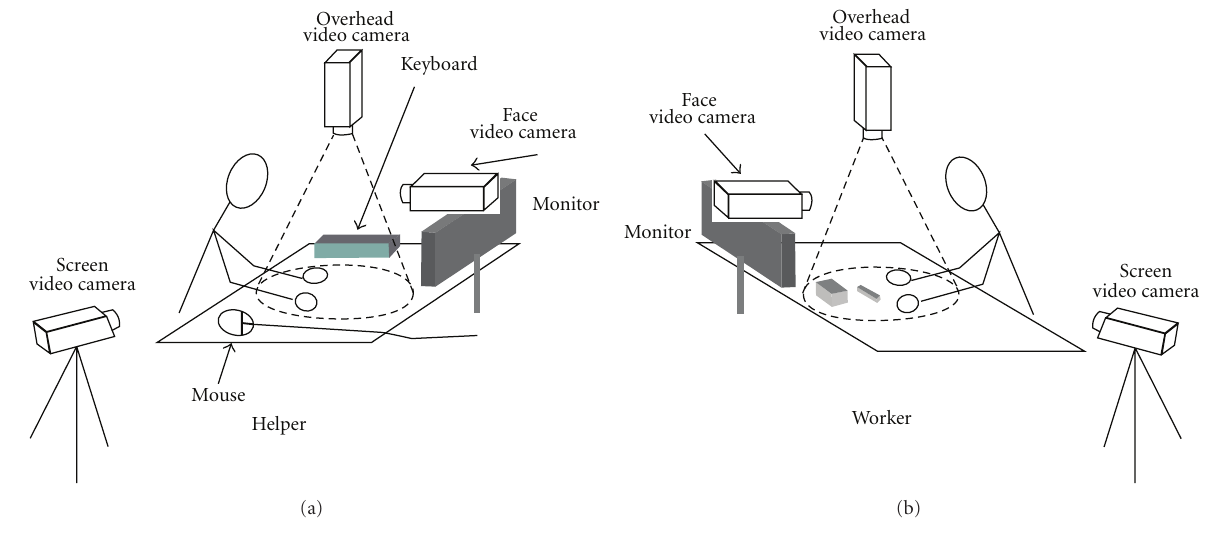
Figure 2: Technical setup (adapted from Kirk et al. [8]).